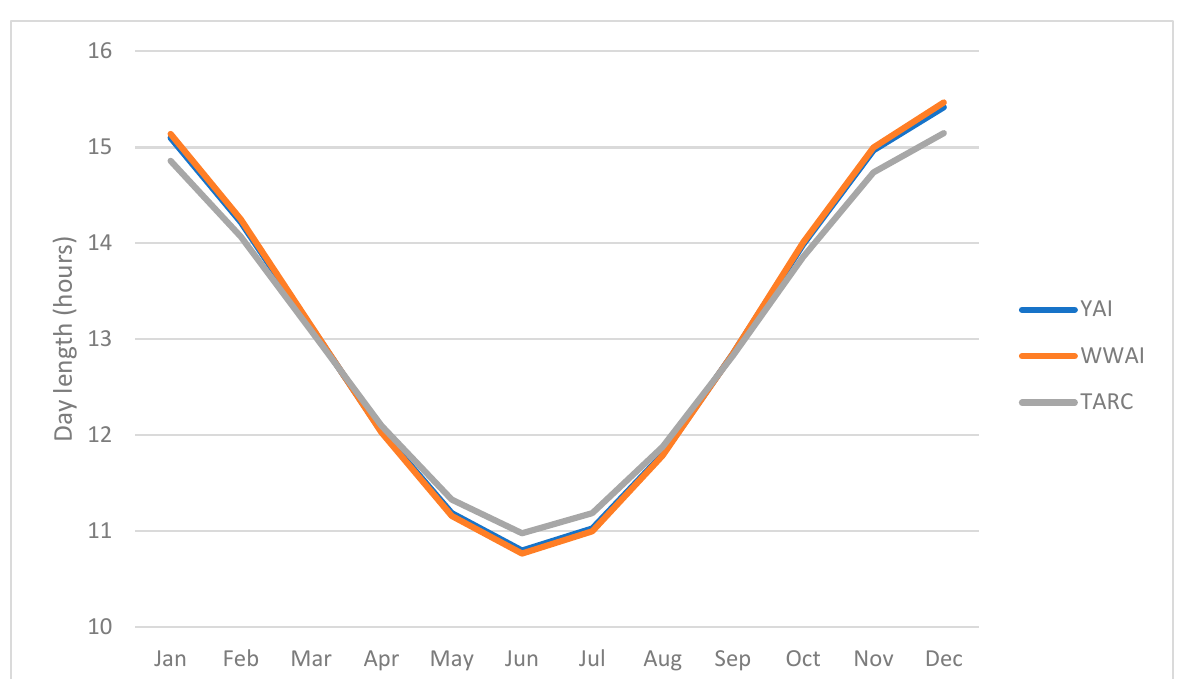
Figure 1. Day length (photoperiod) in hours at YAI (and LFS), WWAI and TARC.